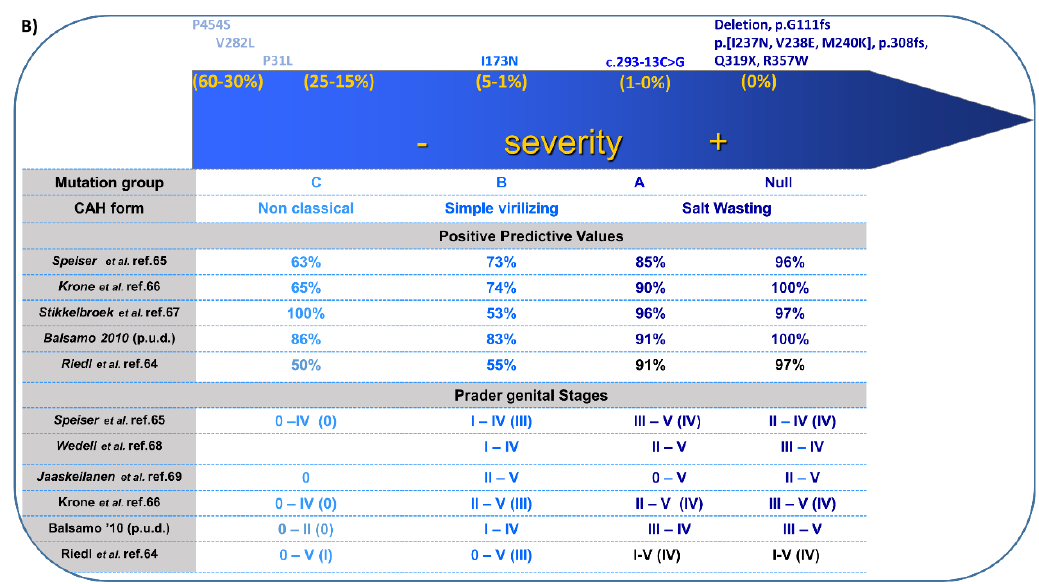
Figure 3. ( A ) Structure of the human CYP21A2 gene with the number of the pathogenic variants described in both 46,XX and 46,XY patients (modified from Simonetti et al. [59]. ( B ) Genotype / phenotype correlations of CYP21A2 mutations according to the salt-wasting severity (PPV) in female and male patients and Prader stage classification in 46,XX subjects; p.u.d., personal unpublished data. (modified from Krone and Arlt [66]).